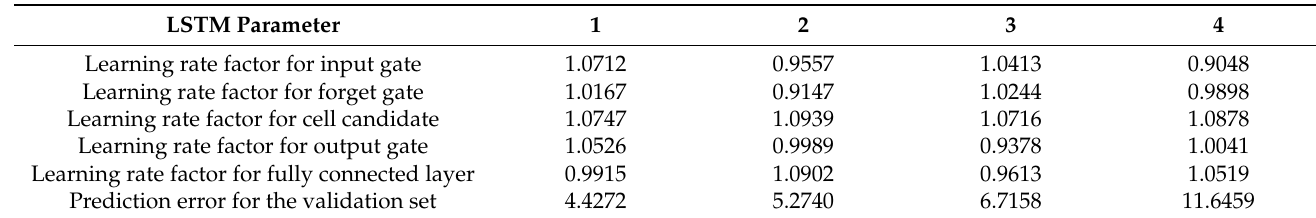
Table 10. The values of LSTM parameters in the four evaluations of BA (engine dataset).